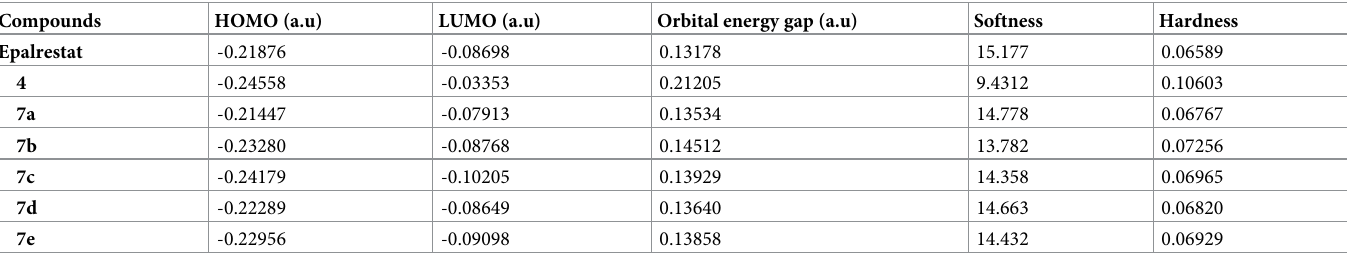
Table 2. Theoretical electrostatic results of Epalrestat, compound 4 and 7a-e. Compounds HOMO (a.u) Softness Hardness